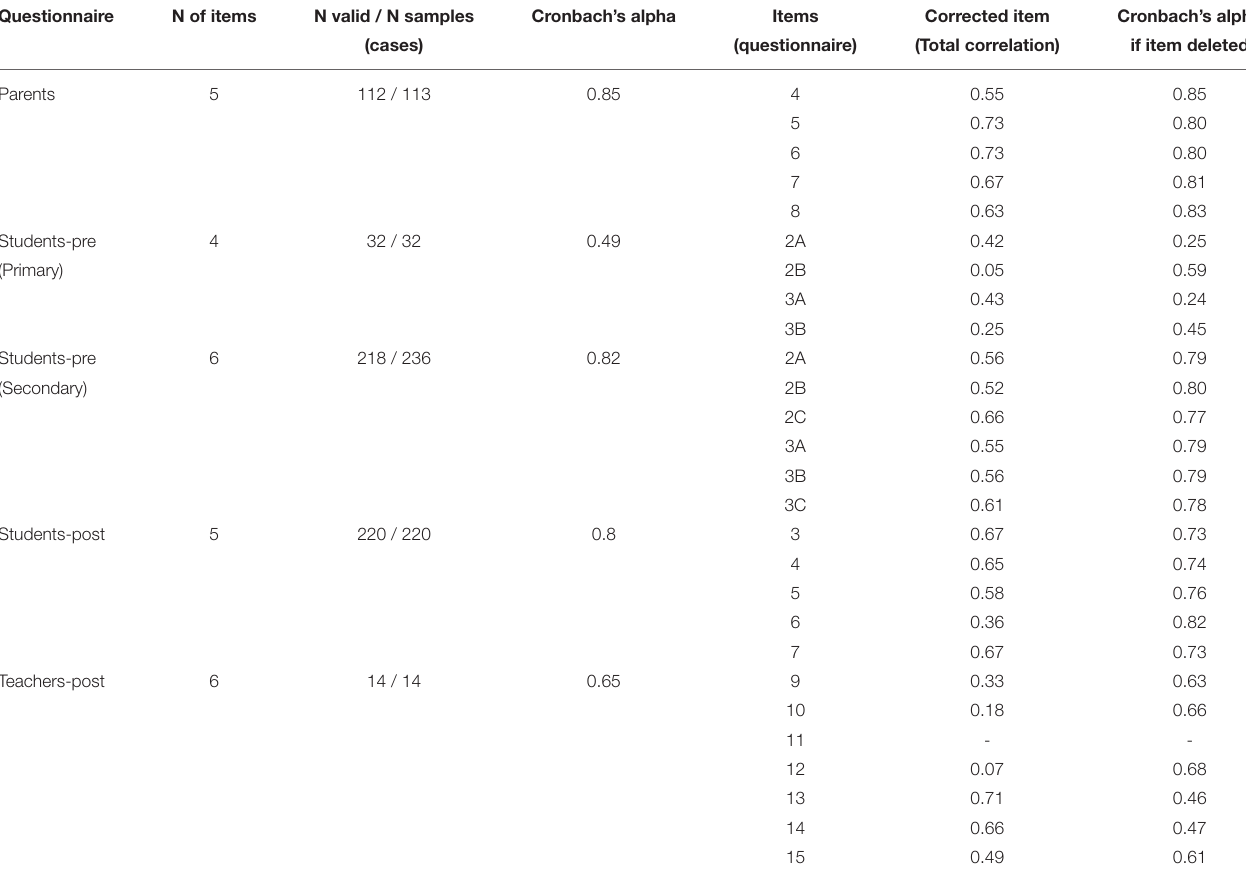
TABLE 10 | Summary of the Cronbach’s alpha results in phase II.